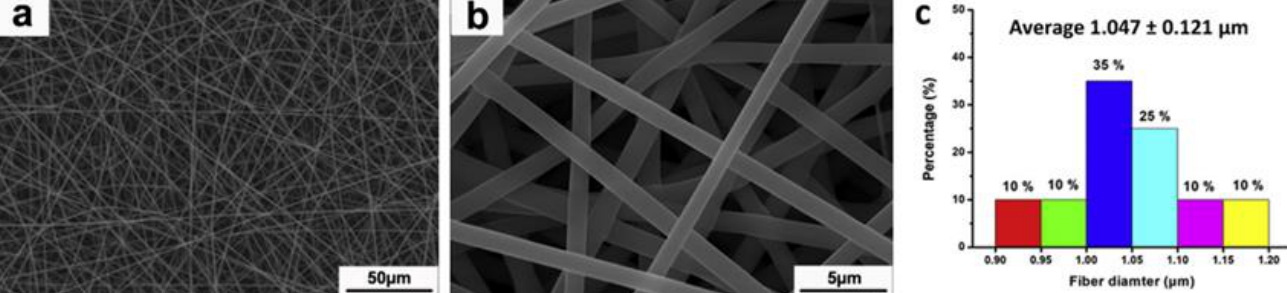
Figure 10. The morphology of the electrospun SiOC fibers after being calcined at 1000 °C ( a ) the low resolution and ( b ) the high resolution; ( c ) the diameter distribution of the electrospun SiOC fibers after calcined at 1000 °C (Reprinted with permission from Ref. [71]. 2018 Elsevier).